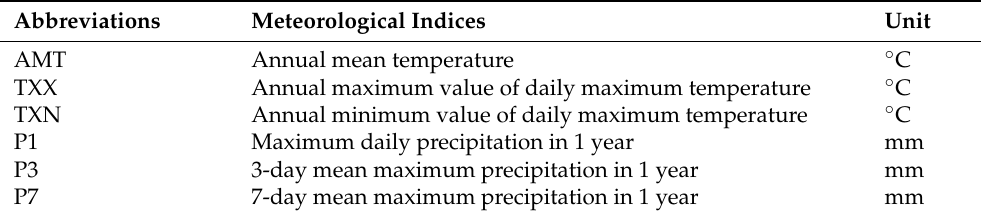
Table 3. Definitions of the six temperature and precipitation indices used in this